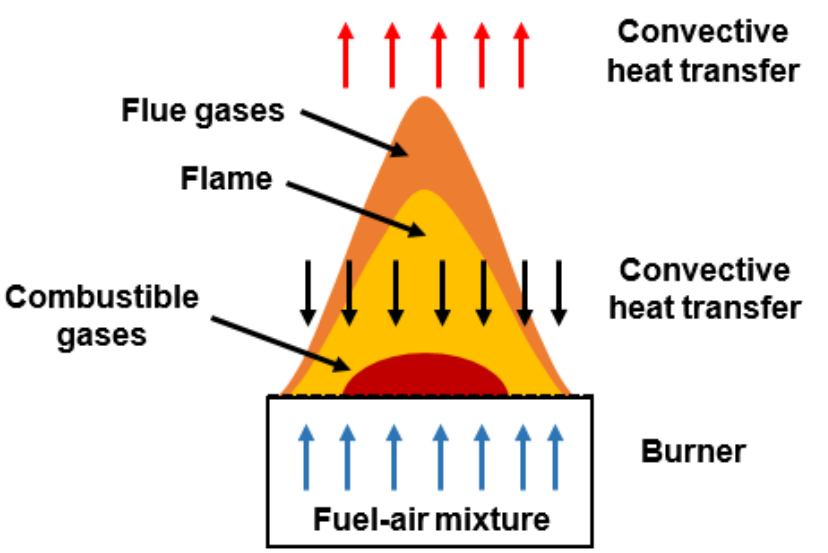
Figure 2. Schematic representation of combustion process in FFC-based cook-stove. The location of flame is controlled by restricting the reaction zone within a desirable limit by controlling the flame speed. The flame speed is in turn affected by several factors such as the composition, amount, and speed of the fuel–air mixture. The energy transfer is by direct impingement of the turbulent jets, i.e., the flame on pan surface. During com- bustion, some part of the total energy content of the fuel is lost by incomplete combustion, and the rest is released as heat energy in the product gas. This heat energy is transported to the cooking load mainly by convection; however, a considerable quantity of heat energy is lost to the surroundings by radiation and convection. As the FFC-based burners are characterized by the release of combustion products with low emissivity and thermal con- ductivity, the contributions of radiation and conduction from combustion products to the load are negligible [22]. Consequently, the FFC-based burners (including the commercial cook-stoves) are less fuel-efficient, and also possess unenviable characteristics such as in- ferior stable flammability limits, a high emission of toxic pollutants, and low power den- sity [23]. 2.2. Cook-Stoves with Heat Recirculation Principle As discussed above, only a part of the heat energy from the hot gas is transported to the load in FFC-based cook-stoves. This can be solved only by the efficient combustion of fuel–air mixture and an enhanced transfer of heat energy to the load, which could be ef- fectively accomplished by providing means to recirculate the heat energy from the hot combustion products to the incoming fuel–air mixture without their direct mixing. The process of transferring enthalpy from the combustion products to the incoming fuel–air mixture is often termed ‘excess enthalpy burning’. Furthermore, the combustion process in burners operating on the heat recirculation principle can sustain in much leaner condi- tions than the flame in conventional burners. Higher burning velocities and flame temperatures are the characteristics of such flames, hence the name ‘superadiabatic’ combustion. Many researchers reviewed the heat- recirculation principle based burners and described their operation [24–27]. Cook-stoves with the heat recirculation principle can be classified into two groups: external heat recir- culating burners and internal heat recirculating burners. The example of external heat re- circulating burners is the Swiss roll burner [28], where the heat is transferred from hot product to cold reactant in a double spiral heat exchanger. Another example is the one which was developed by Jugjai and Sanitjai [29], where a Porous Medium (PM) was used to convert the enthalpy of the exhaust gases to thermal radiation which is then fed back to the burner inlet. On the other hand, internal heat recuperation is realized by facilitating